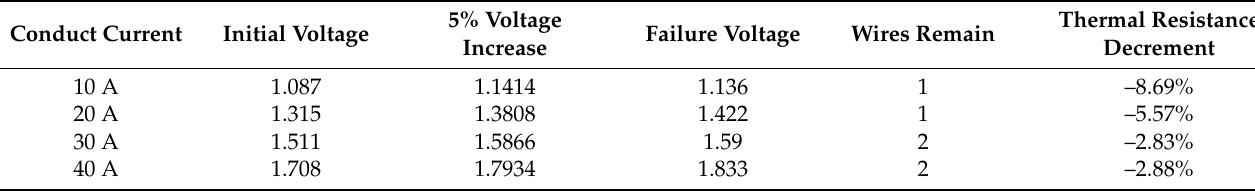
Table 4. Failure Criteria of Bond Wires